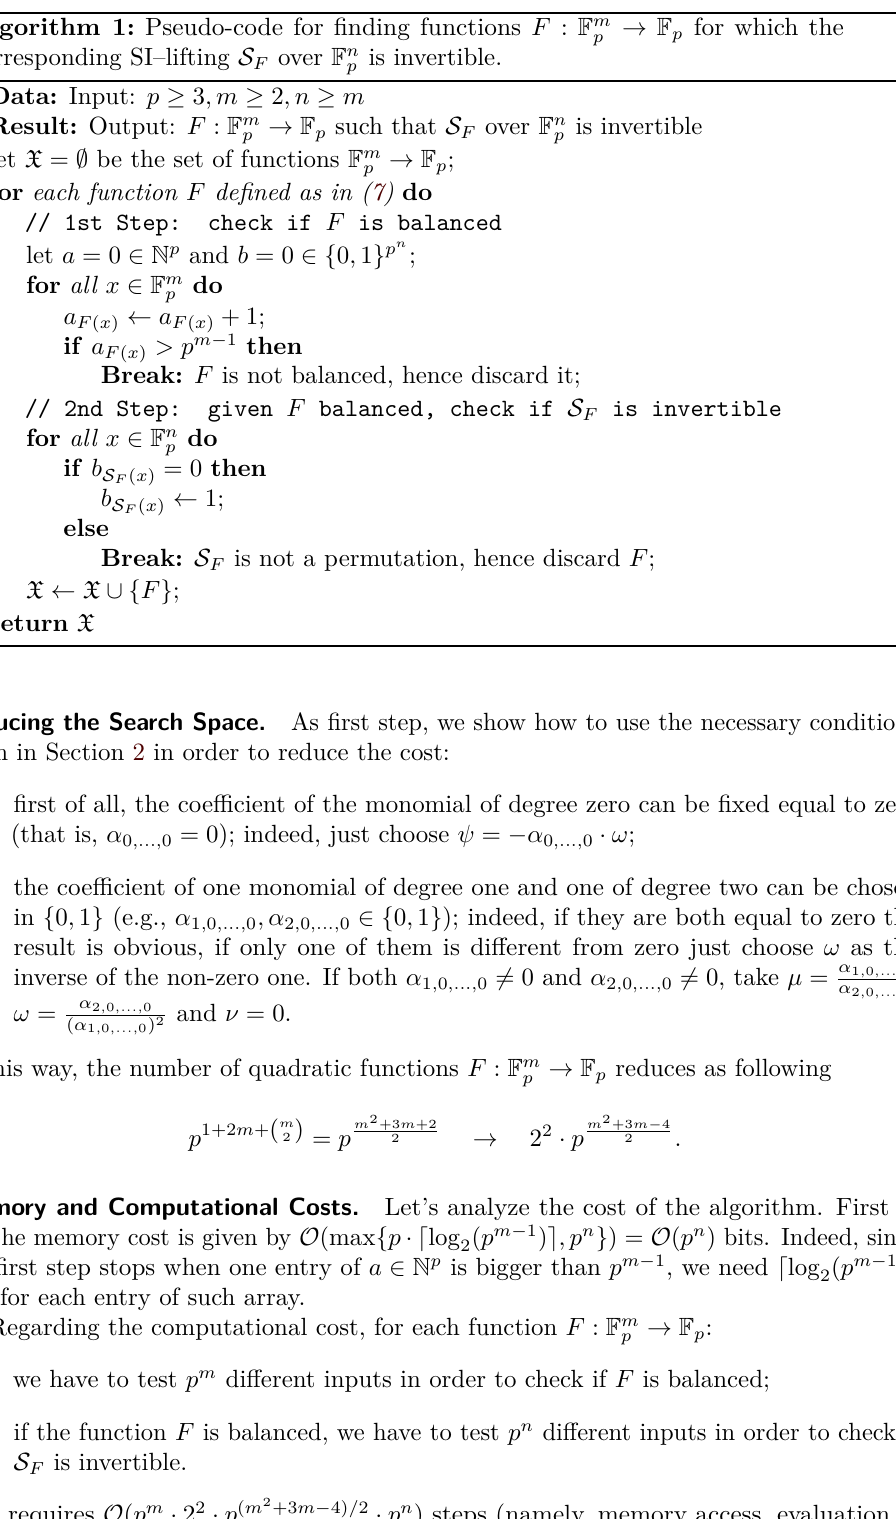
→ F p for which the p